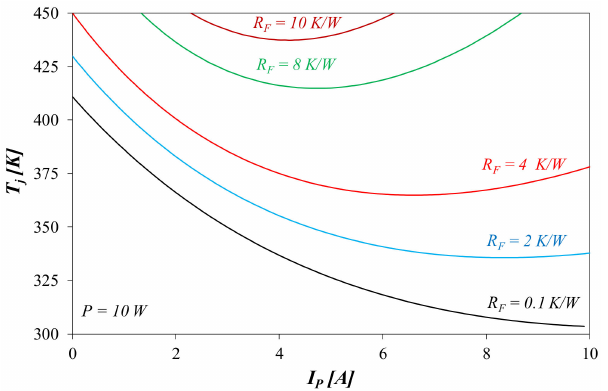
Figure 10. Device junction temperature versus the current I p at selected values of fins thermal